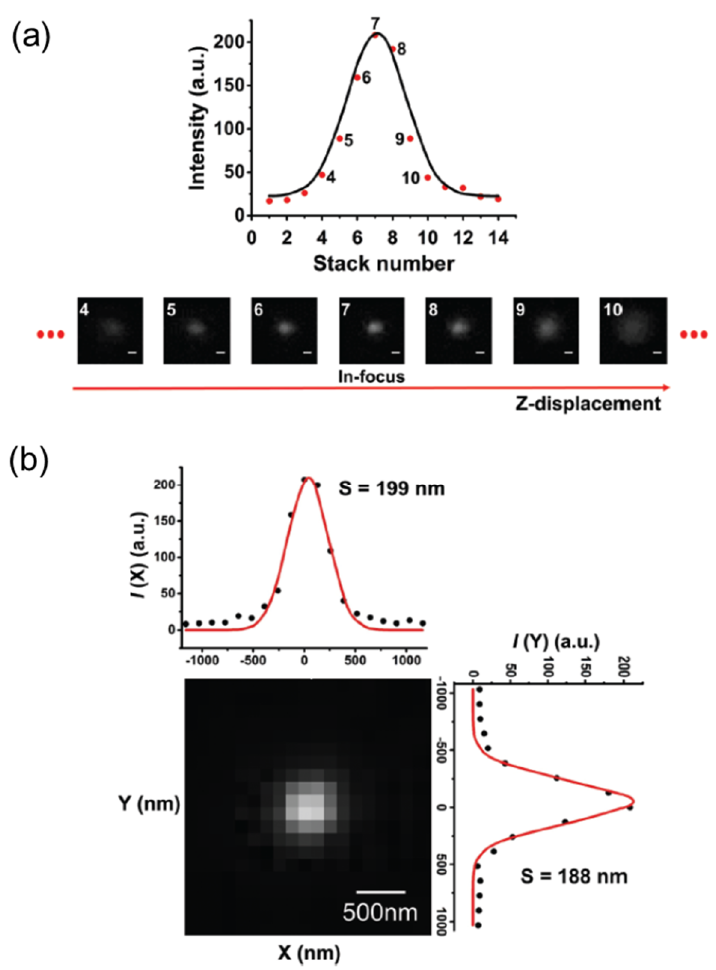
Figure 2. ( a ) The UCNP intensity profile over the z -axis and the Gaussian fit. UCNP images were acquired by 980 nm excitation (731 W cm − 2 ) with an exposure time of 70 millisecond. Scale bar: 500 nm. ( b ) A typical 3D centroid determination. The UCNP on the section image that is closest to the z-coordinate determined in ( a ) is chosen for the localization. The numbers in the intensity plots represent standard deviations of the Gaussian function [16]. Reproduced by permission of the PCCP Owner Societies. Copyright 2018 Royal Society of Chemistry. Table 1. Pros and cons of confocal, epifluorescence, and TIRF microscopy. Confocal Epifluorescence TIRF Rapid detection No out-of-focus background Rapid detection Pros Low signal loss Sectioning along z-axis Low background Deep penetration Slow detection Cons High background Small excitation depth Signal loss